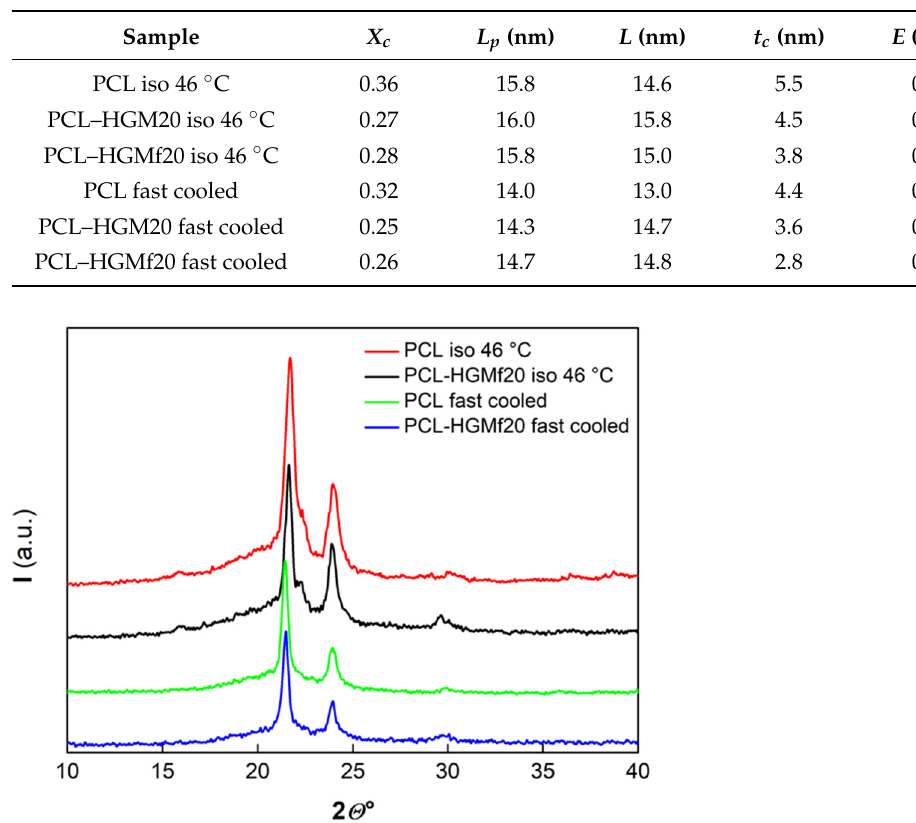
Table 3. Structural and supermolecular parameters of pure PCL and composites.